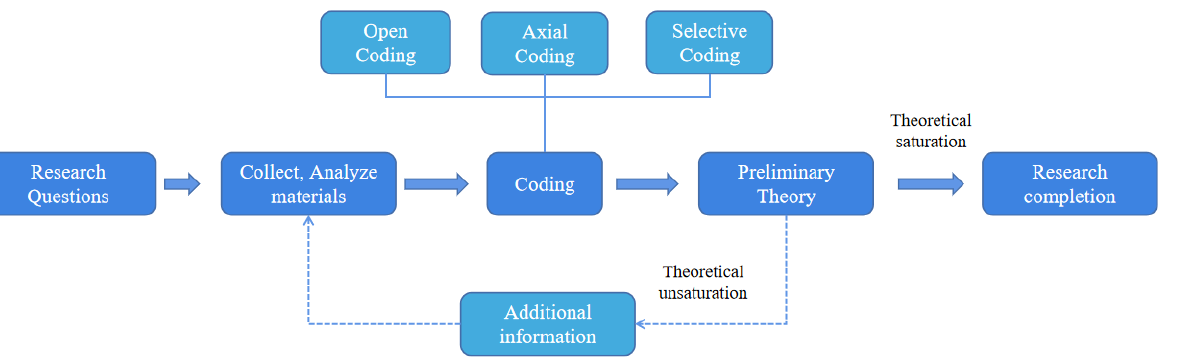
Figure 1. Research steps in